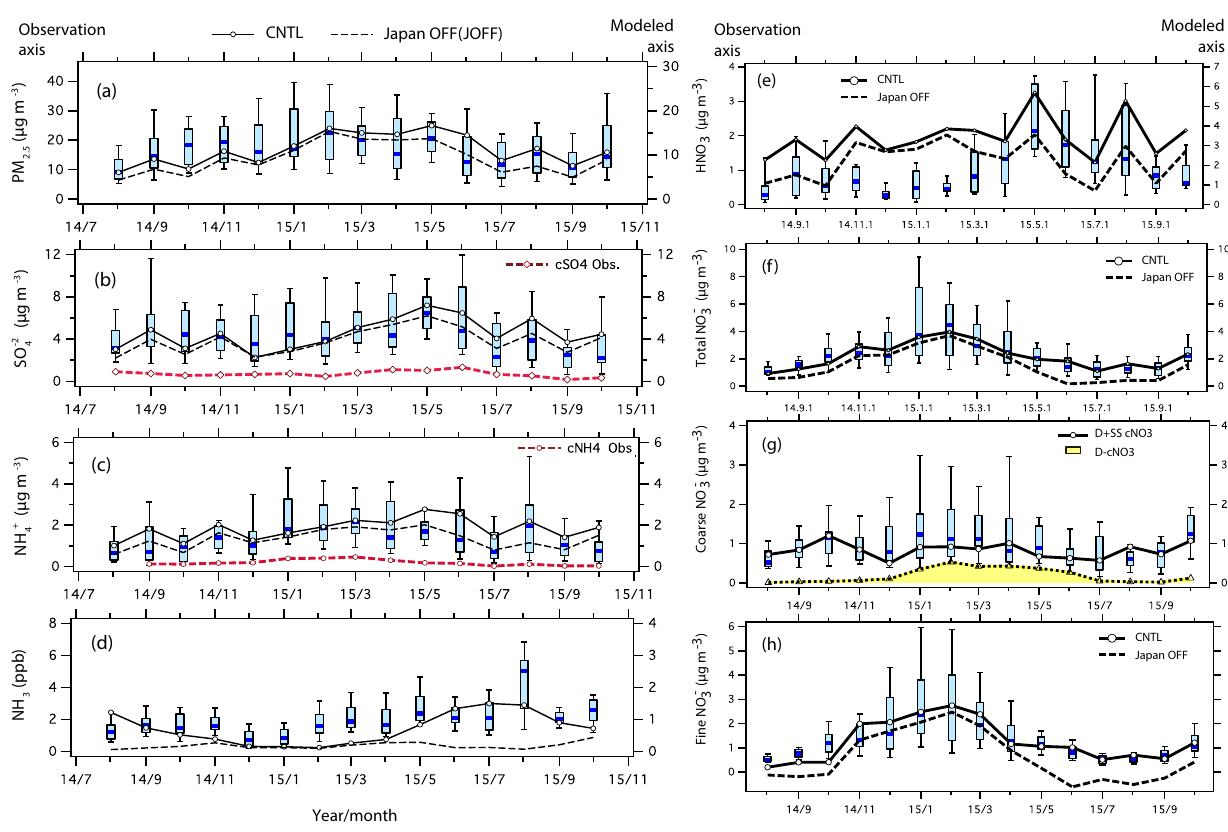
Figure 4. Monthly average plots of (a) PM 2 . 5 , (b) fine SO 2 − (h) fine NO − . Box-and-whisker plots show observations (10th, 25th, 50th, 75th, 90th percentile values). Red lines in panels (b) and (c) show 3 ACSA-observed coarse-mode concentrations. Black lines are modeled monthly averages; the black straight line indicates the baseline model (CNTL), and the black dashed line except (g) indicates the sensitivity experiment of Japanese emission reduction (JOFF). For (g) , the black dashed line shows the modeled dust coarse NO −